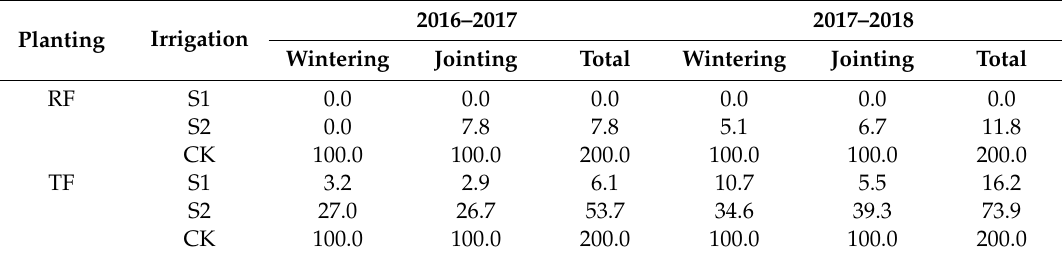
Table 1. Seasonal amount of irrigation given in each treatment during the two wheat growth stages (mm).